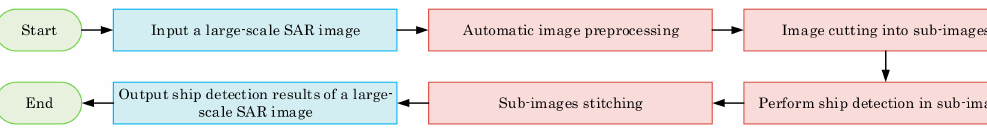
Figure 14. Fully automatic detection flow based on LS-SSDD-v1.0 to train network models. From Figure 14, the fully-automatic detection flow is as